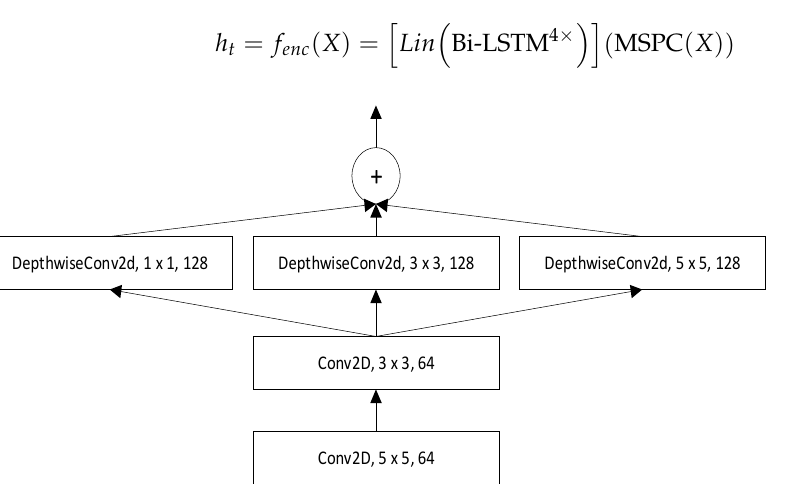
Figure 1. Illustration of the proposed MSPC architecture. The size of the convolution kernel and the number of output channels are introduced in detail.